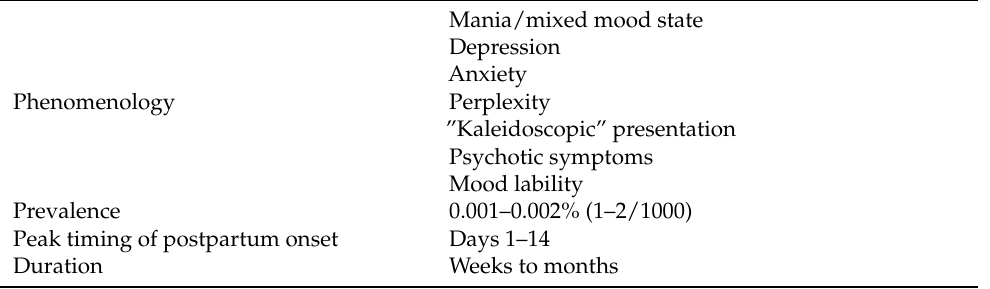
Table 1. Phenomenology and epidemiology of postpartum